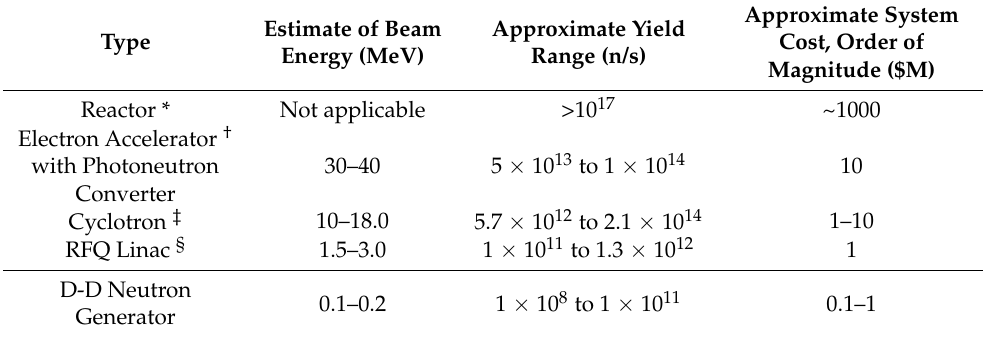
Table 4. Example neutron sources [30–32] with estimates of yields and system costs. Estimate of Type